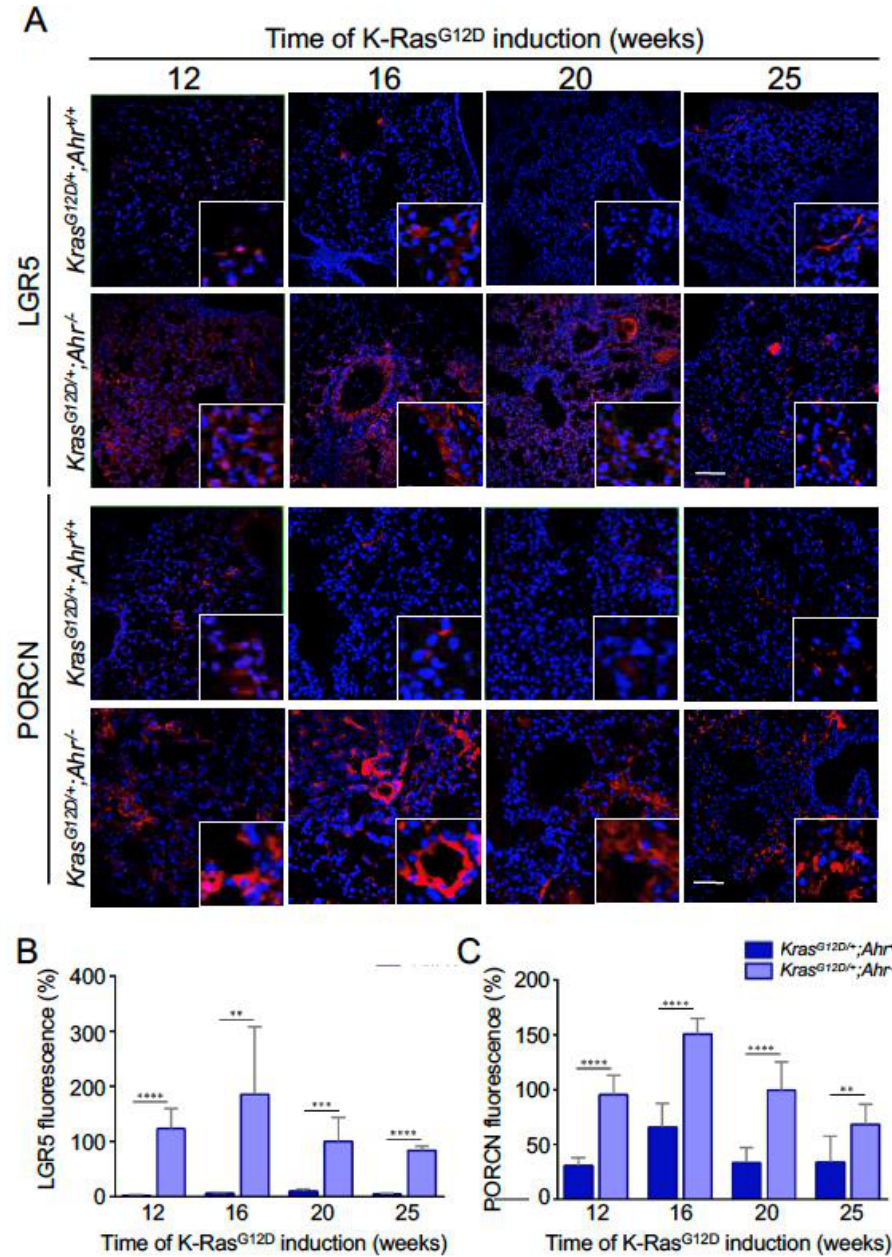
Figure 5. Markers of the cancer stem cell niche LGR5 and PORCN are overrepresented in Ahr-null K-RasG12D mice. ( A ) Sections from K-Ras G12D/+ ; Ahr +/+ and K-Ras G12D/+ ; Ahr − / − lungs were analyzed by immunofluorescence to identify cancer stem cells expressing LGR5 (upper) or PORCN (lower) as surrogate markers for tumor progression. ( B , C ) The percentages of LGR5-positive ( B ) or PORCN-positive cells ( C ) after K-Ras G12D activation from 12 to 25 weeks were quantified. The conjugated secondary antibody was Alexa-633 for both markers. Sections were analyzed using an Olympus FV1000 confocal microscope and the FV10 software (Olympus, Shinjuku, Japan). DAPI staining was used to label cell nuclei. Bar corresponds to 100 µ m. Data are shown as mean + SD (** p < 0.01; *** p < 0.001; **** p < 0.0001).